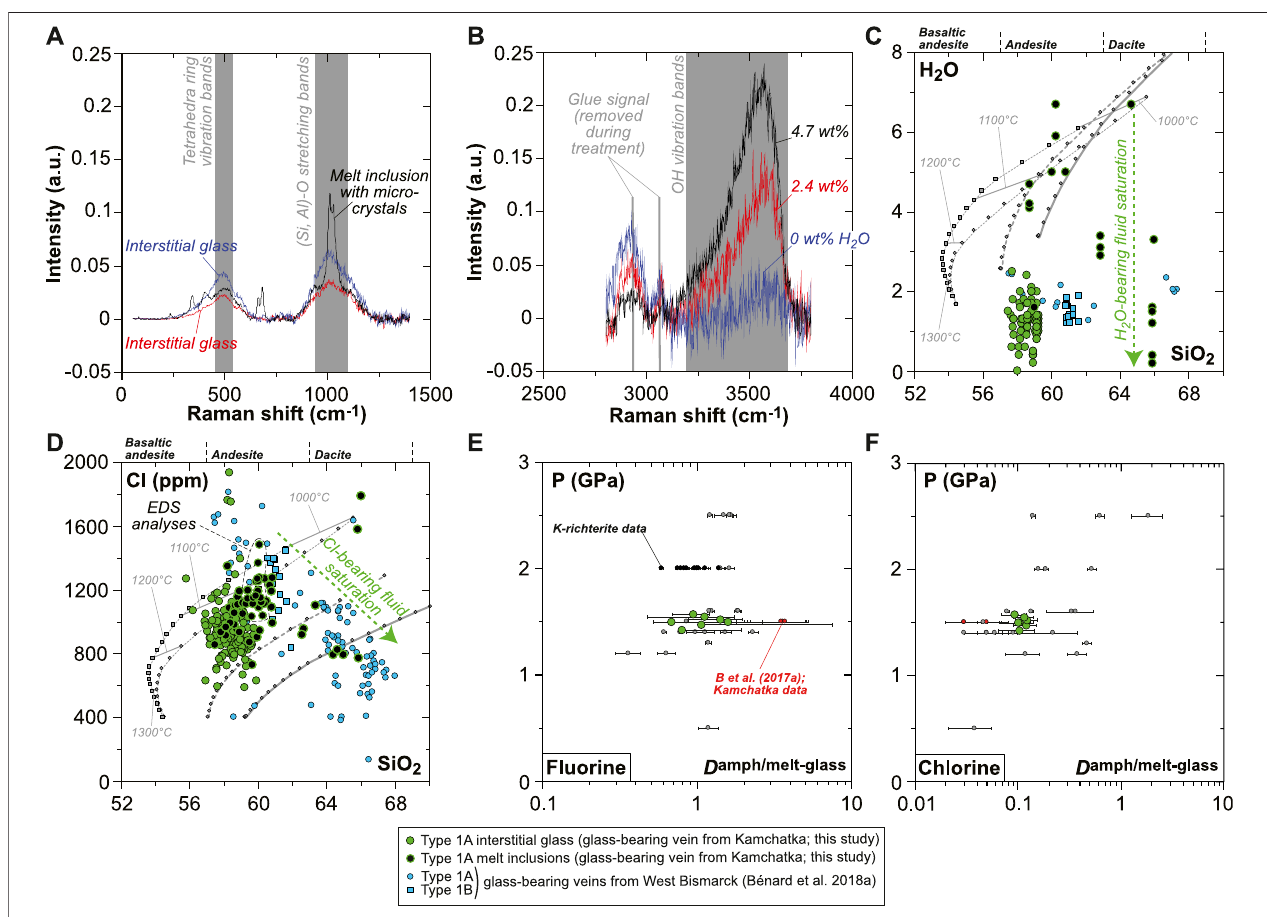
FIGURE8| Volatile(H 2 O,F,andCl)compositionsandpartitioningdataforthenewKamchatkaveininthisstudy(glassandmeltcompositionsarenormalizedonan anhydrous basis). (A,B) Representative Raman spectra for interstitial glass and MIs showing (A) signature of micro-crystals in MIs and (B) variable H 2 O contents traced bychangingOHvibrationbandintensities. (C) H 2 Oand (D) ClcompositionsoftheveinMIsandinterstitialglass(H 2 OandSiO 2 inwt%). (E,F) Pressureplottedagainst (E) F and (F) Cl partition coef fi cients between amphibole and glass. Also shown in (C) are isobaric models forthe liquid lines ofdescentofharzburgite-derived melts at 1 GPa (gray lines), calculated by Bénard et al. (2018a) with pMELTS. The same models are used in (D) for Cl, assuming 400 ppm in the starting melt and a purely incompatible behavior for this element during crystallization. Also shown in (E,F) are literature data for F and Cl partitioning, including experiments for calcic amphibole (gray dots; Hauri et al., 2006; Dalou et al., 2014; Van den Bleeken and Koga, 2015; Flemetakis et al., 2021) and K-richterite (black dots; Edgar and Pizzolato, 1995). Partitioning data acquired on natural rocks by Bénard et al. (2017a) (melt pockets in Kamchatka spinel harzburgite mantle xenoliths) are shown with red dots.